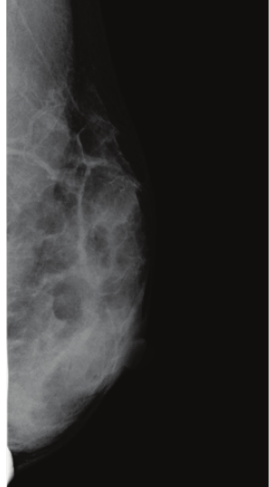
Figure 1: Mammography. The mass was not detected.